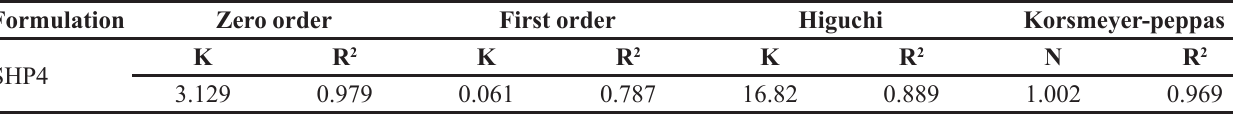
TABLE IV - Release parameters of chitosan nanoparticles (SHP4) Formulation